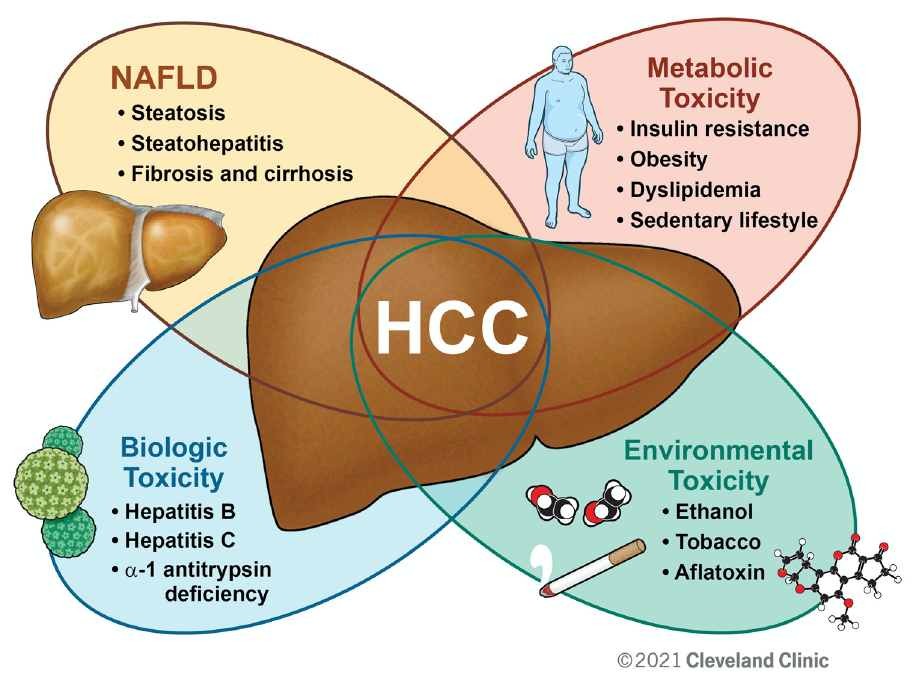
Figure 1. The Role of NAFLD and Metabolic Syndrome in HCC. Illustrated is a working model by which diverse factors may compound one another to promote HCC. While individual patients will have certain “drivers” of disease, emphasis should be placed on improving metabolic parameters as a primary preventive strategy against HCC from chronic liver disease of various